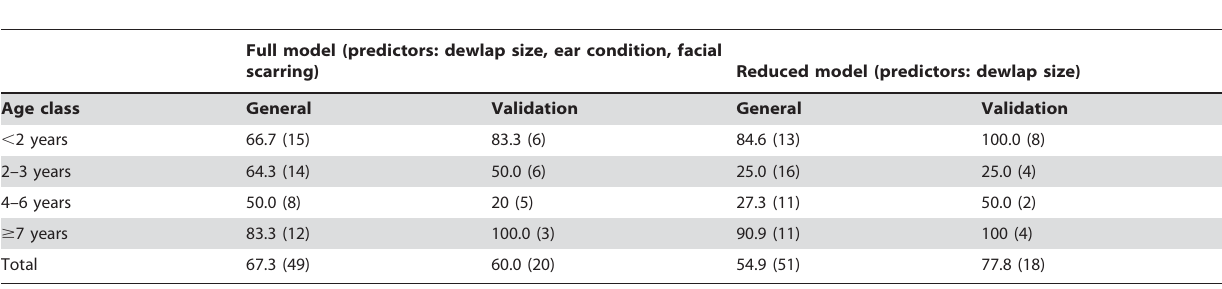
Table 3. Relative success rates of discriminant models classifying male leopards into their respective age classes based on principal component factor scores for dewlap size, ear condition, and facial scarring.